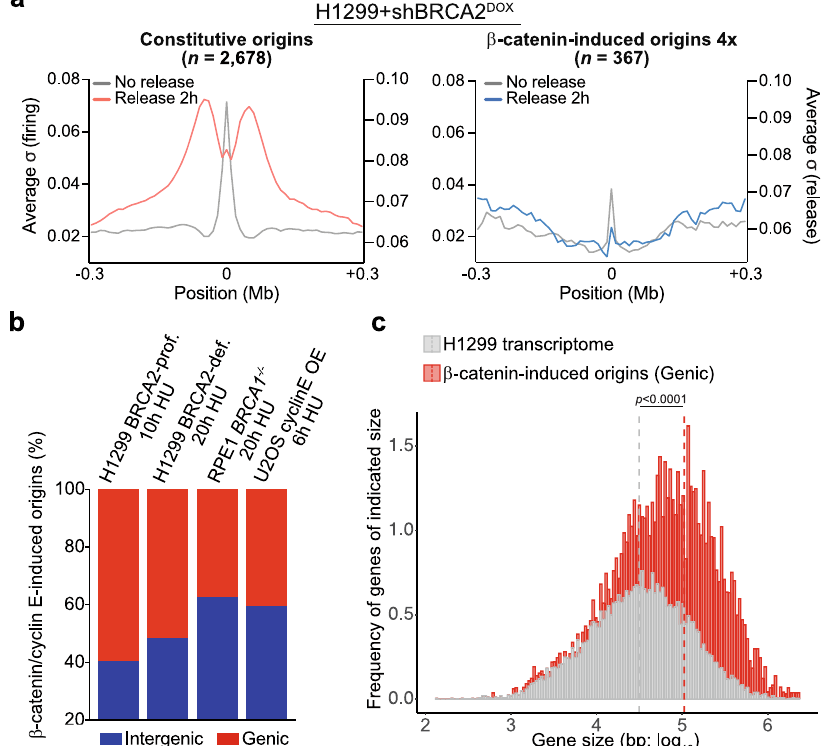
Fig. 5 β -catenin-induced fork collapse and origin fi ring in genic vs inter-genic regions. a Genome-wide average fork progression in BRCA2-de fi cient H1299 cells treated with 25 μ M EdU 30 min before cell collection. b Genome-wide distribution of β -catenin-induced or cyclin E-induced origins in BRCA2- pro fi cient and -de fi cient H1299 cells, BRCA1-de fi cient RPE1 cells and U2OS cells, based on gene annotation. c Size frequency distribution of all protein- encoding genes in H1299 cells (grey) and of protein-encoding genes containing β -catenin-induced origins in BRCA2-de fi cient H1299 cells (16 and 20 h after mitotic release; red). Dotted lines indicate mean values for each gene set. Statistical signi fi cance was determined by a two-tailed Mann – Whitney test. Source data for ( b ) is provided in the Source data fi